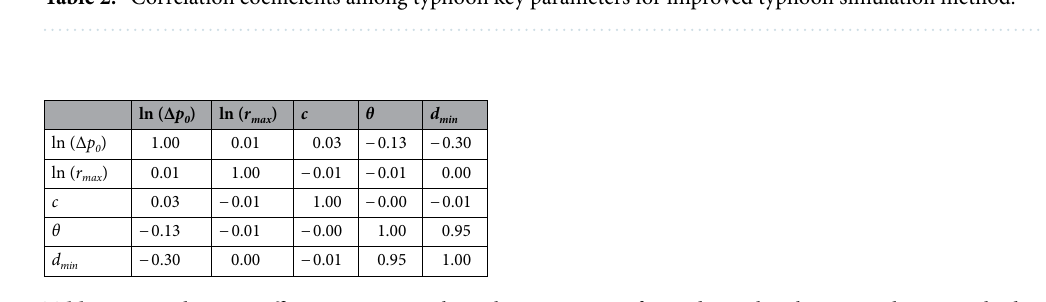
Table 3. Correlation coefficients among typhoon key parameters for traditional typhoon simulation method.